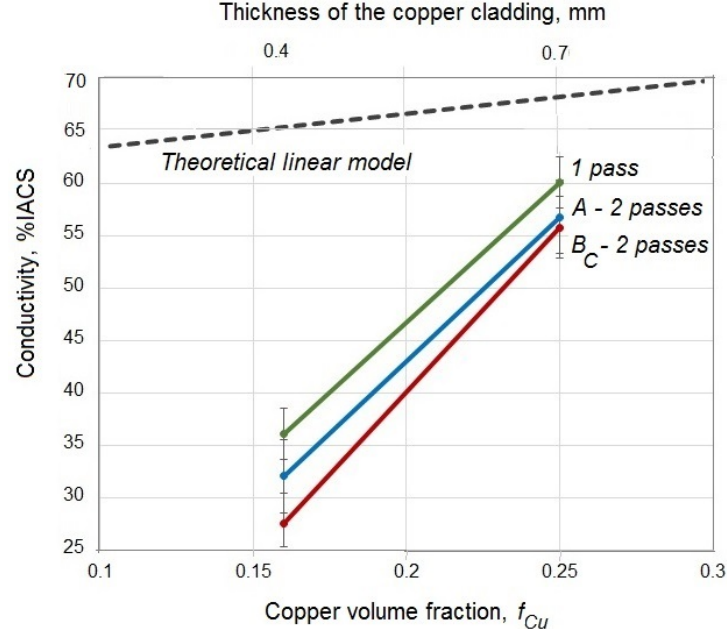
Figure 7. Effective conductivity versus thickness of copper cladding after deformation.